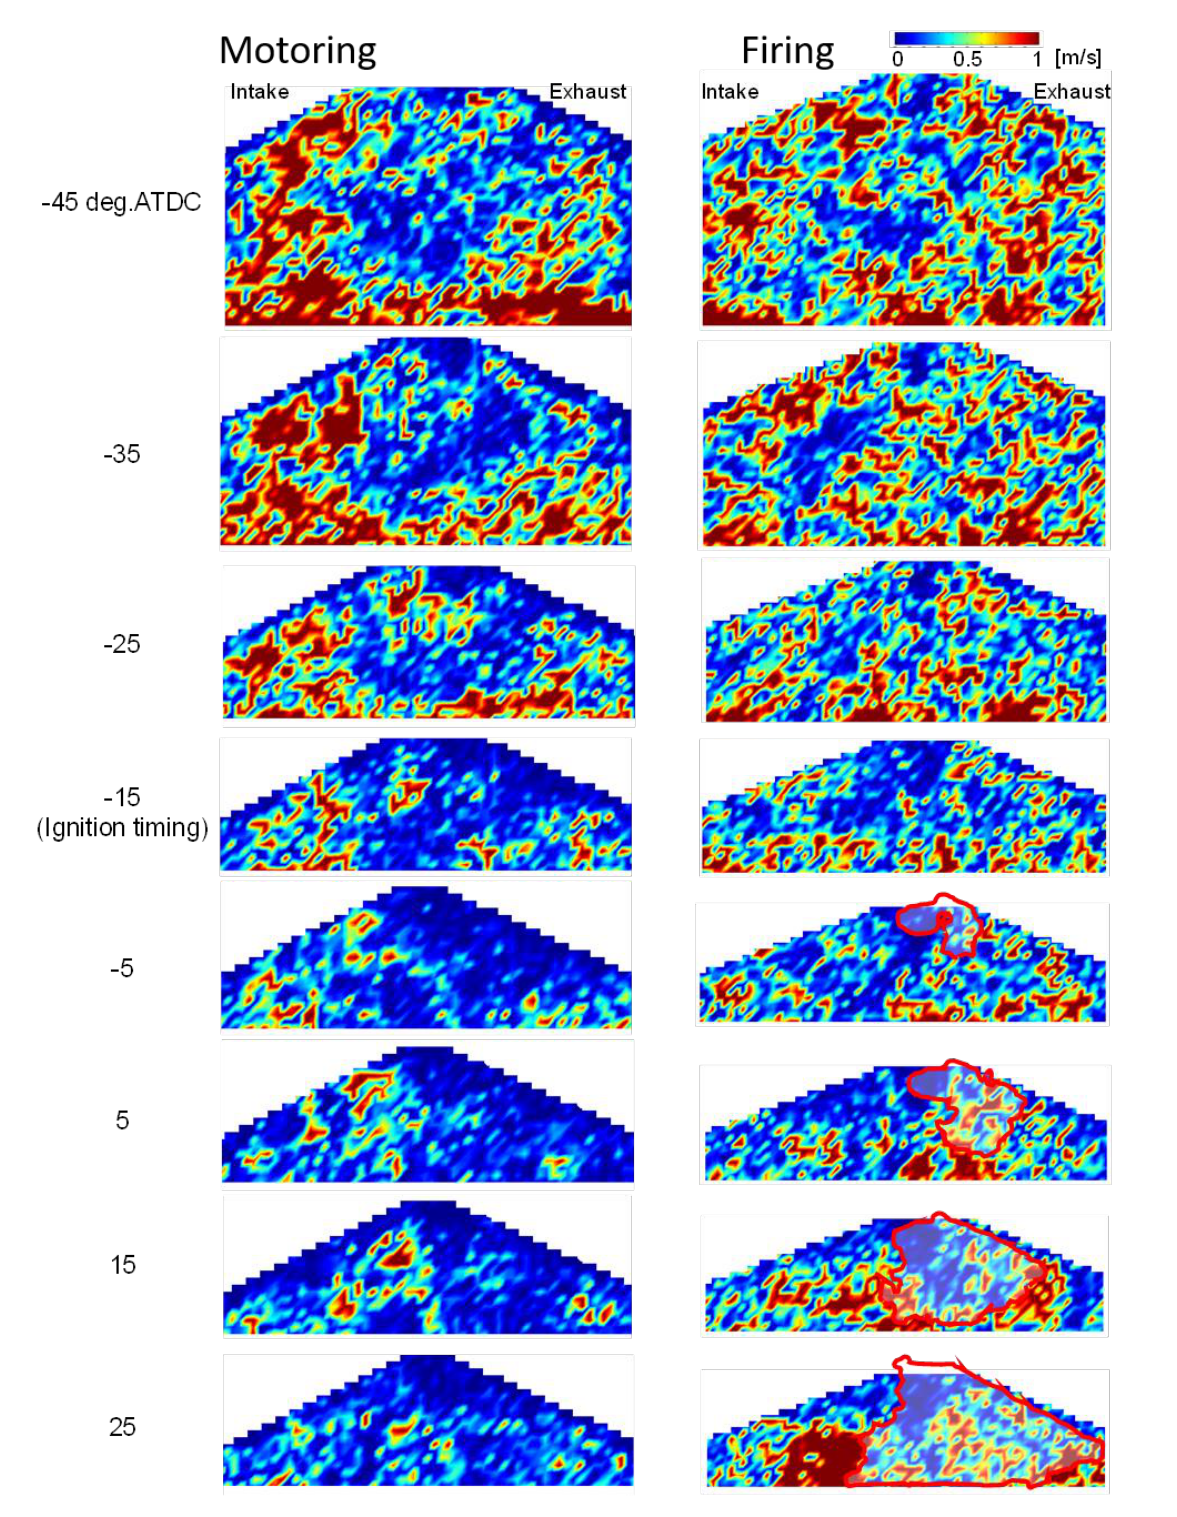
Figure 10. Turbulence intensity of a selected motoring cycle ( left ) and a selected firing cycles ( right ).